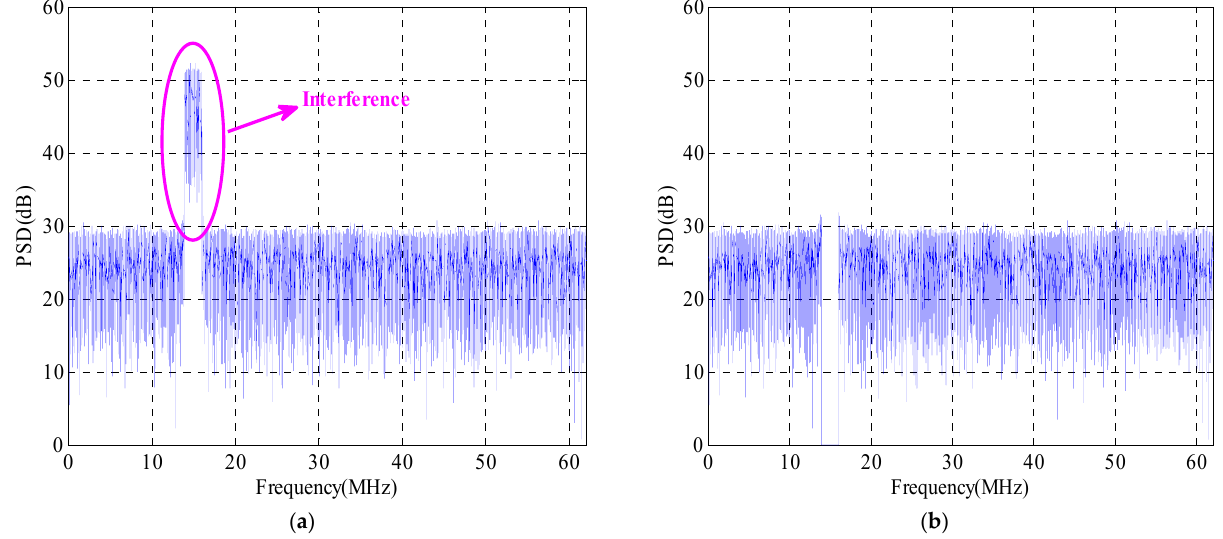
Figure 3. Spectrum before and after anti-jamming: ( a ) before anti-jamming, ( b ) after anti-jamming.